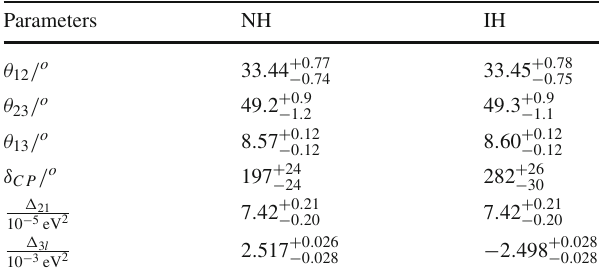
Table 1 Global best-fit values of neutrino oscillation parameters [7,8]. (cid:6) = (cid:6) > 0 ( (cid:6) < 0) for NH 3 l 31 32